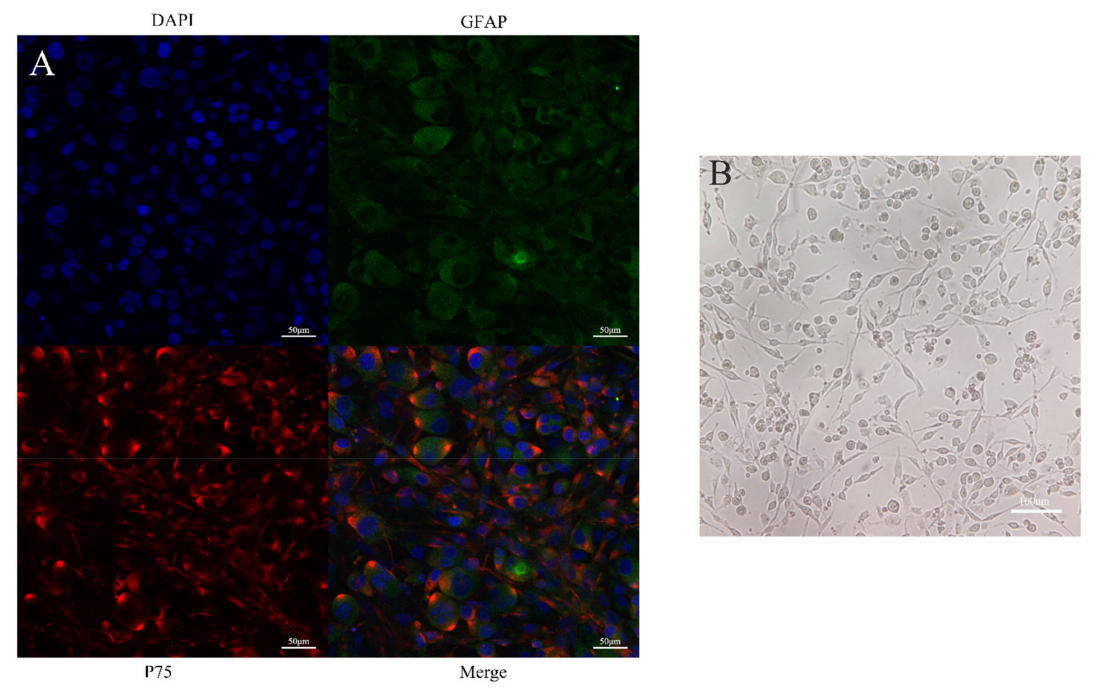
Figure 2. Primary identification of OECs: ( A ) The cells were identified via immunofluorescence analysis on Day 10 of the primary culture. The cell shape was fusiform, the cell body was round, and the two poles became filamentous. OECs are known to express both P75 and GFAP. The results of the immunofluorescence staining showed that most cells were stained red and green, which indicates a positive expression for P75 and GFAP. Number of positive cells: 93.37% ± 0.75. Scale bars, 50 µ m; ( B ) OECs in growth state. The picture shows that the cell body of OEC is round, the poles are slender and spindle shaped, and the growth state is good. Scale bars, 100 µ m. OECs, olfactory ensheathing cells; GFAP, mouse anti-rat glial fibrillary acidic protein.